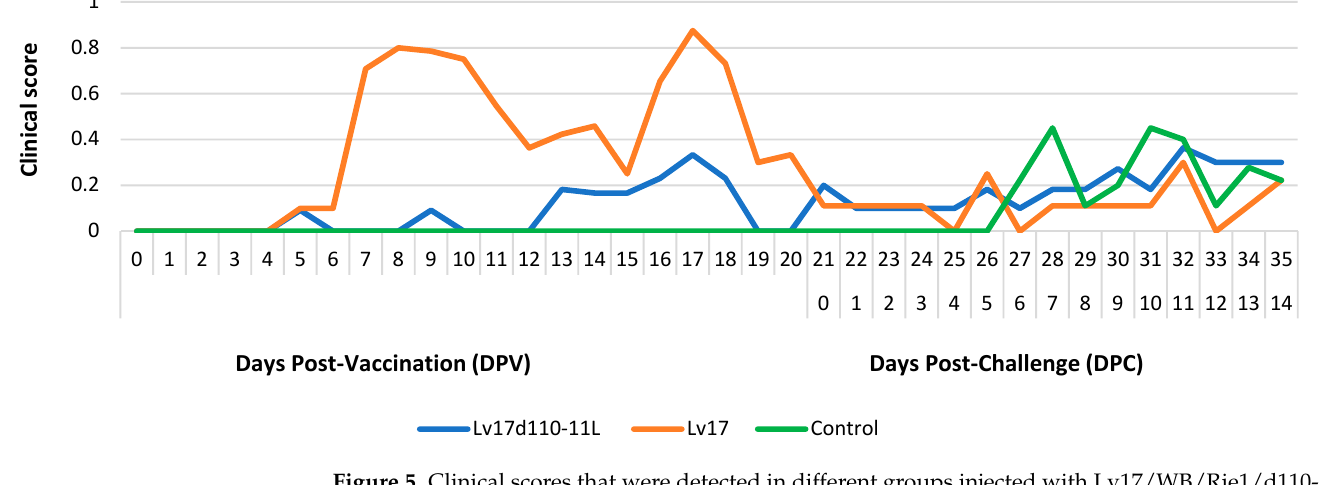
Figure 5. Clinical scores that were detected in different groups injected with Lv17/WB/Rie1/d110- 11L and Lv17/WB/Rie1 of African swine fever virus (ASFV) and challenge-infected with Armenia/07 of ASFV.